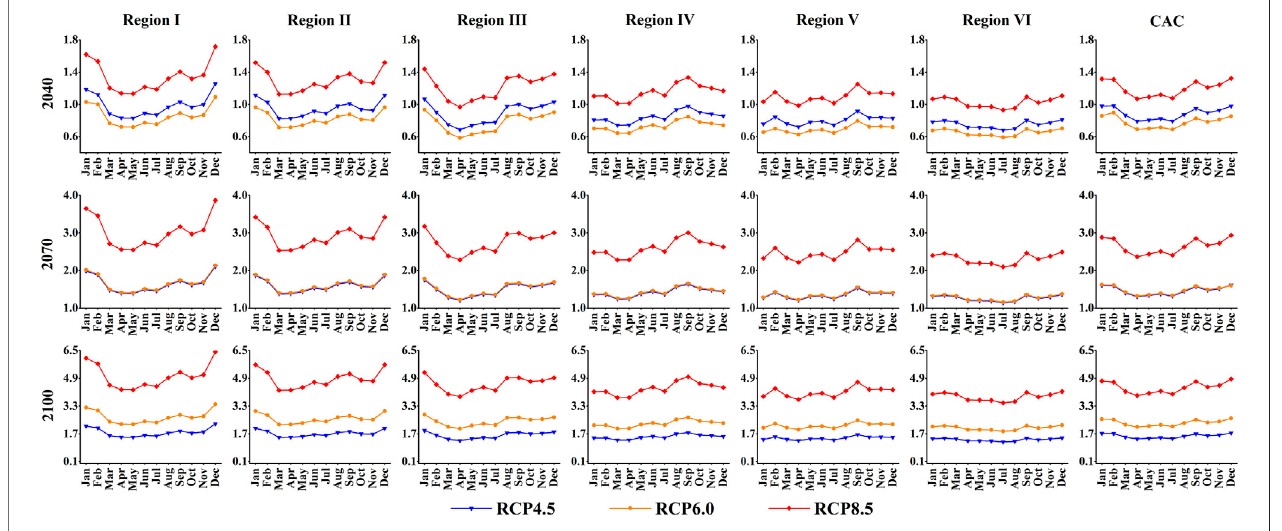
Abbreviations are the same as Table 2 , but for Tmin.